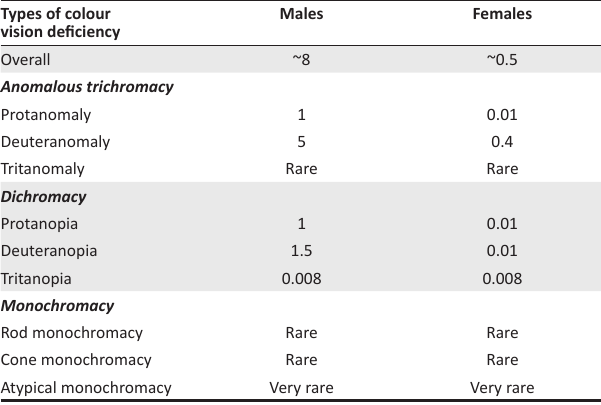
TABLE 3: Prevalence of congenital colour